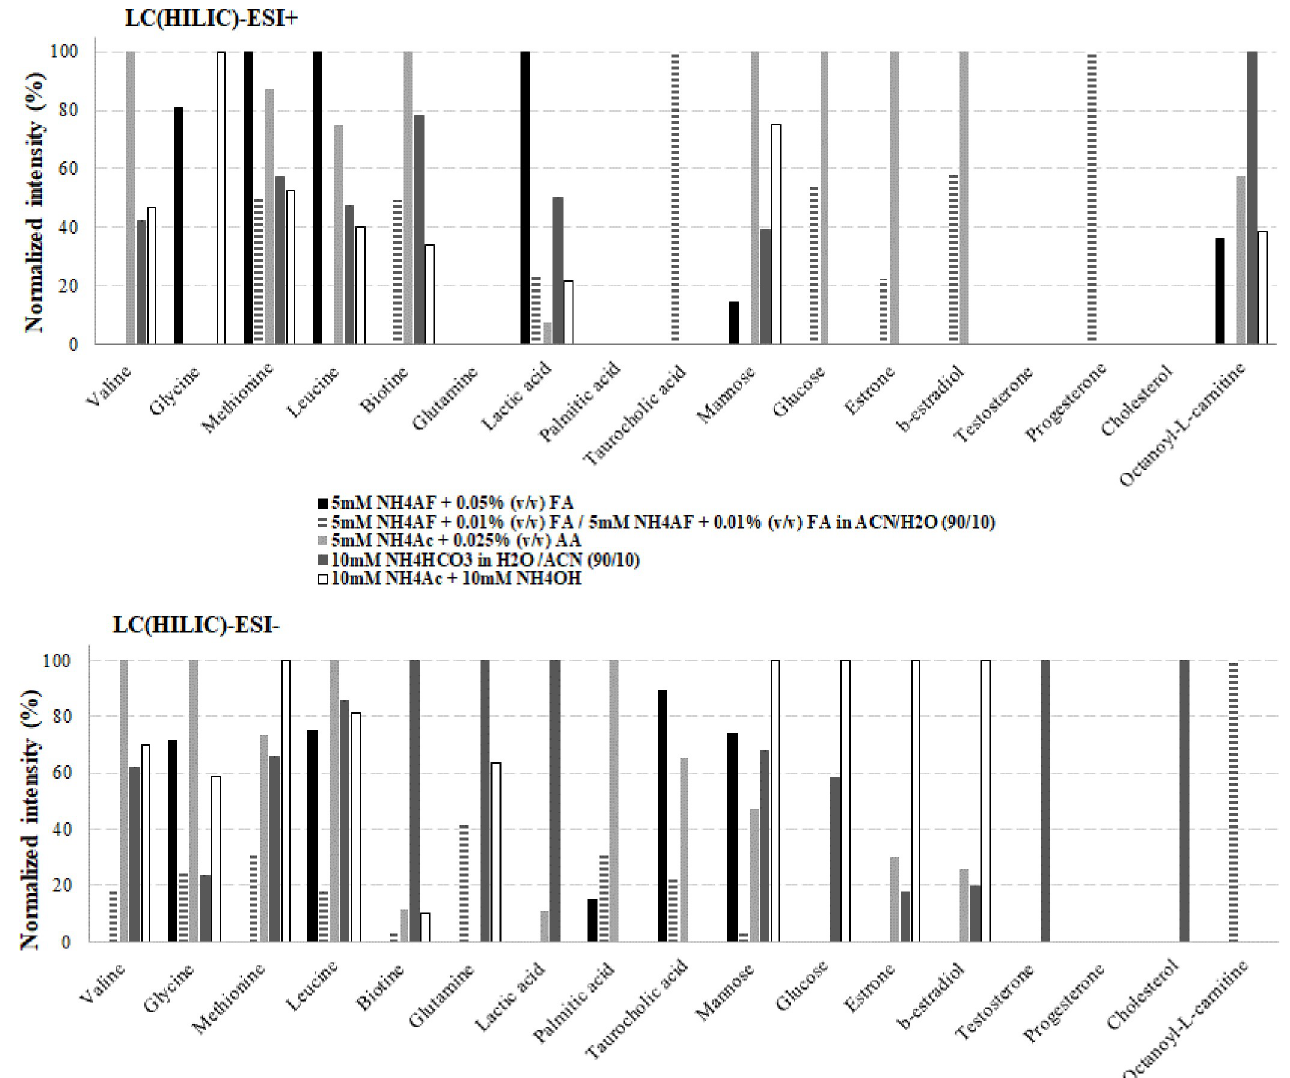
Fig 2. Normalized intensities of targeted metabolites analyzed by LC(HILIC)-(ESI+/-)-HRMS using different mobile phase conditions (results obtained after extraction of 50 mg of fish spiked at 500 μ g/L).